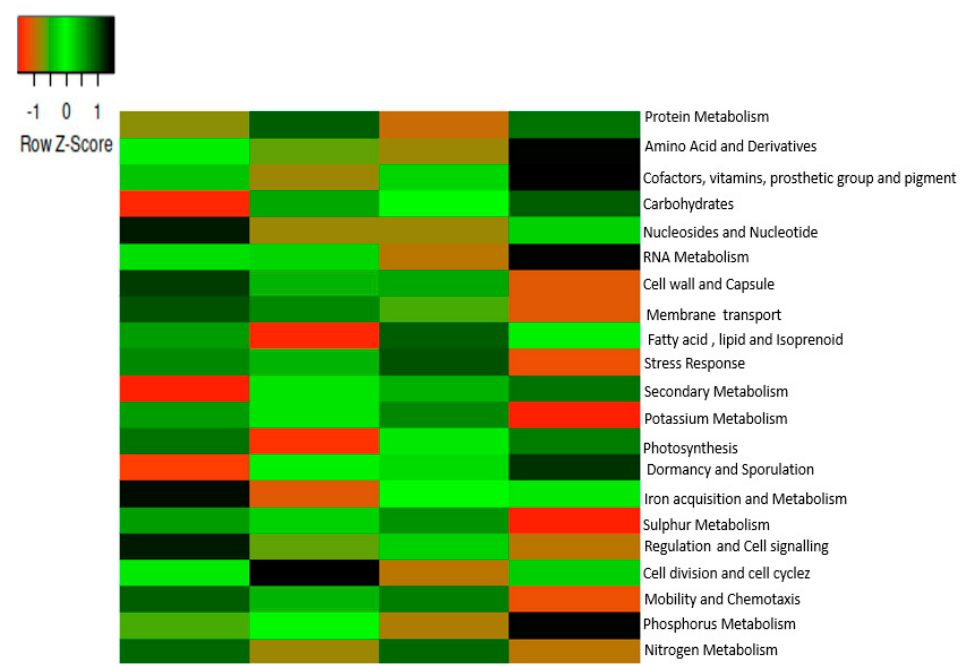
Figure 3. Metabolic functions at level 1 in the SEED subsystem. The scale bar depicts a color saturation gradient based on relative abundances of the functional categories that have been z-score converted. AA, AB, and CA are rhizosphere soil samples while BC is a bulk soil sample.